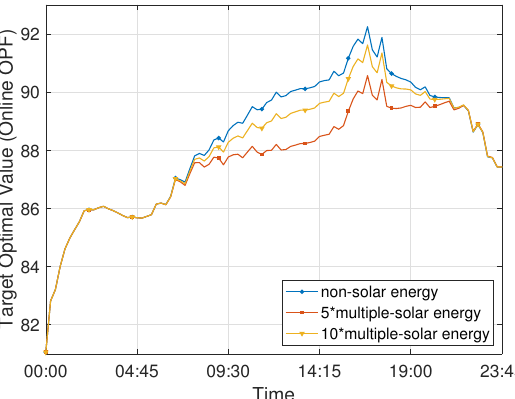
Figure 9. Real-time optimal value of distributed ADMM under different solar configurations.